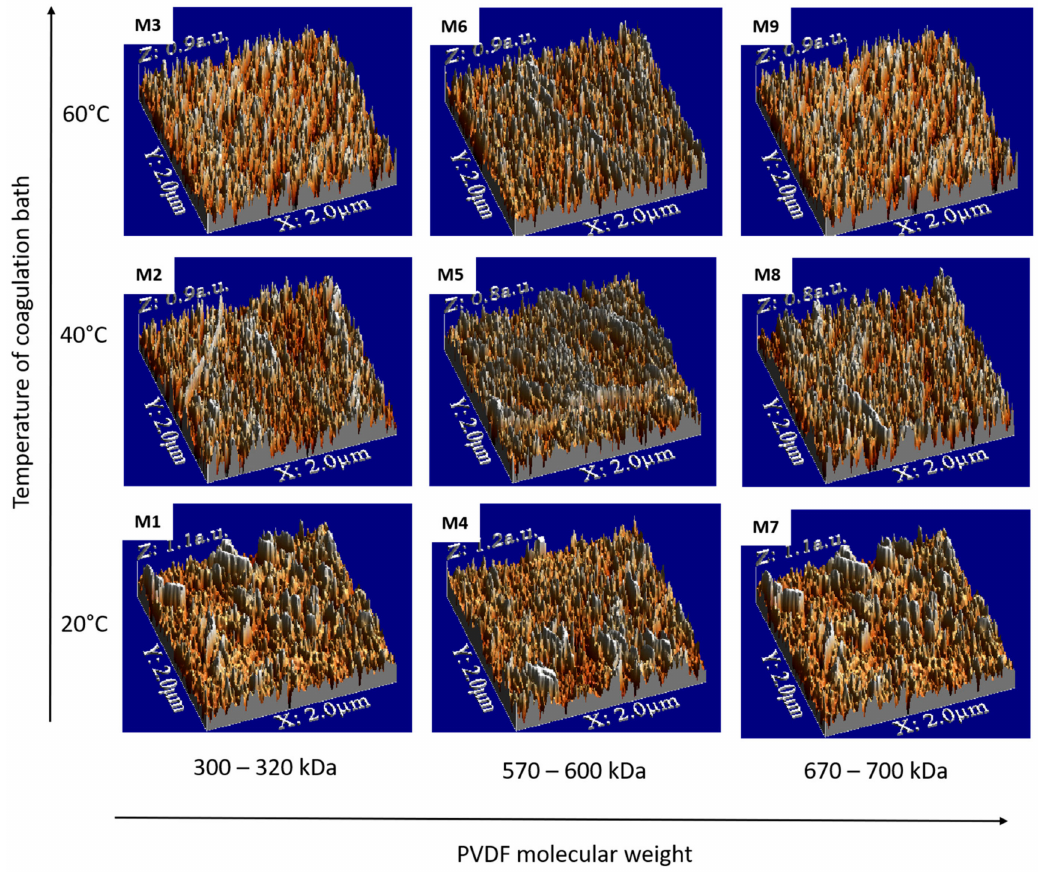
Figure 6. Atomic force microscope (AFM) images of M1–M9 membrane top surfaces.